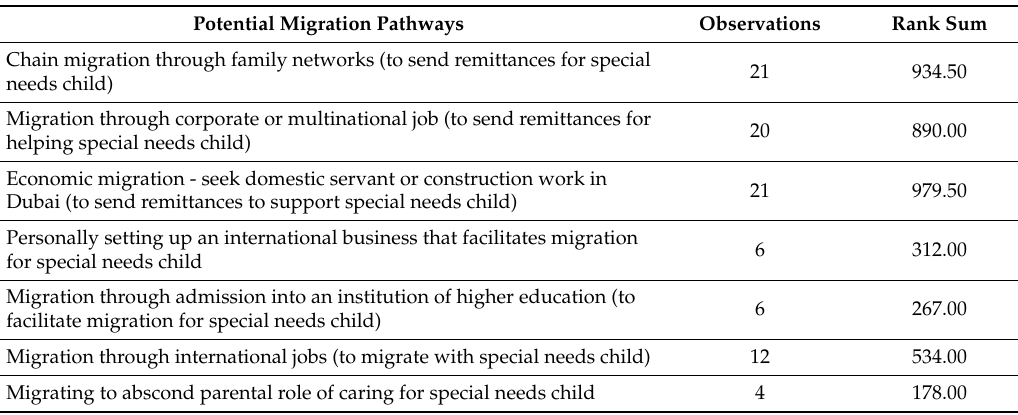
Table 4. Potential Migration pathways of